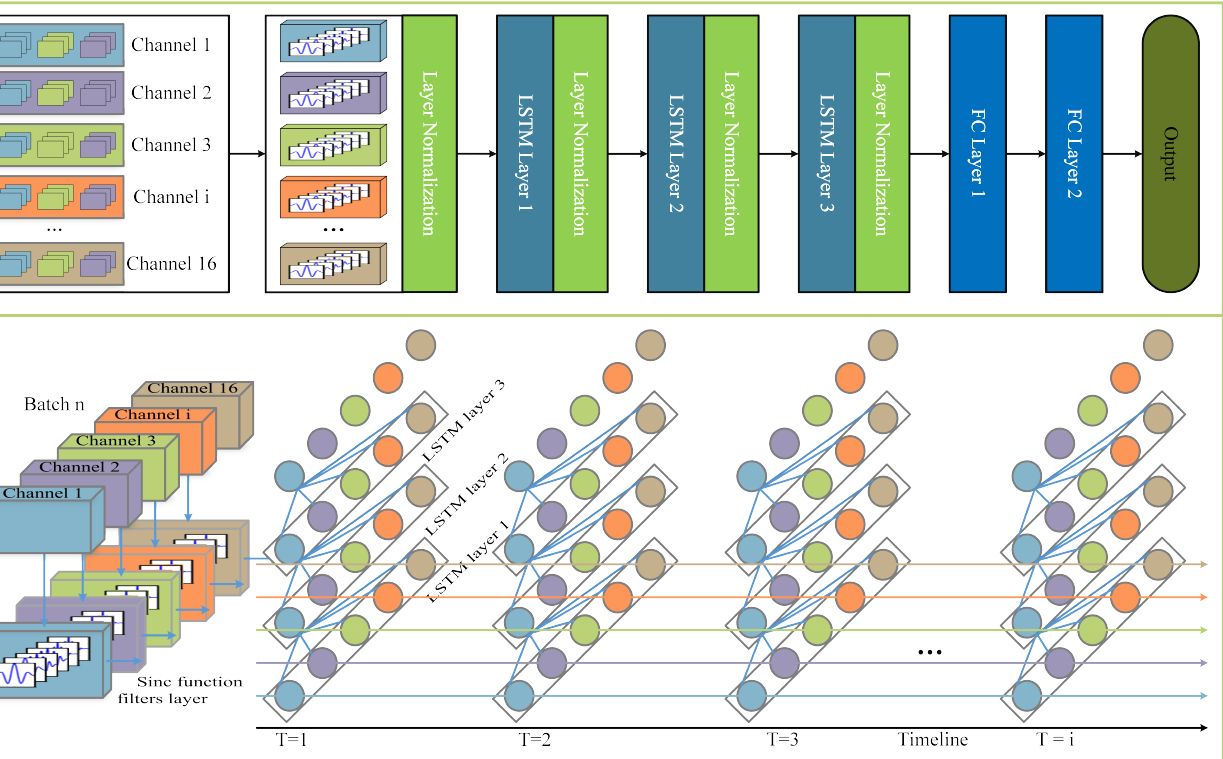
Figure 2. The internal structure of